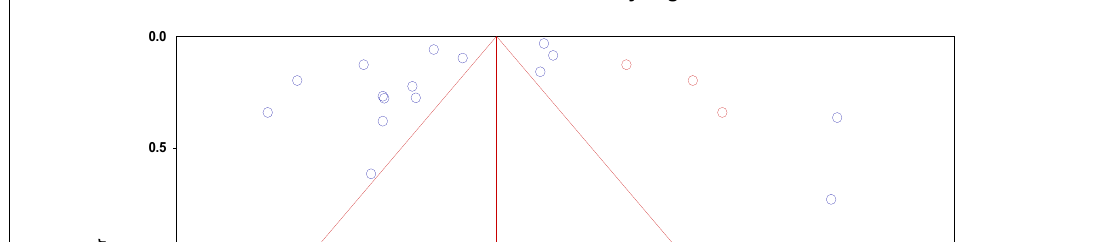
Figure 4. Funnel plot showing publication bias in studies reporting the prevalence of VRE in in poultry in Malaysia. Studies on the right side are fewer than those on the left and thus asymmetrical. The funnel plot is used for the visualization of bias.